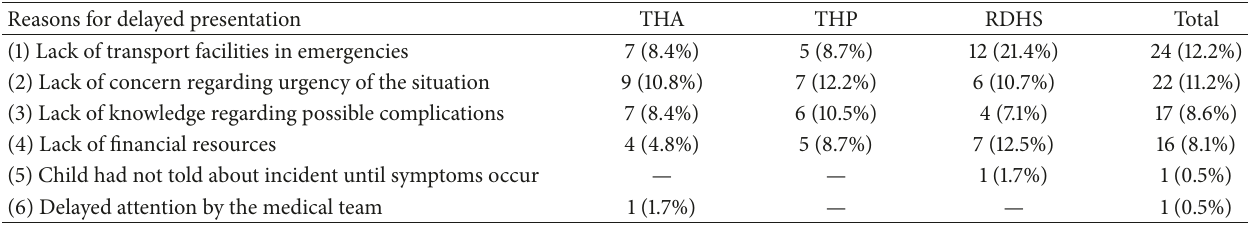
Table 3: Reasons for delayed presentation to primary care unit among children following kerosene oil poisoning in rural Sri Lanka. Reasons for delayed presentation